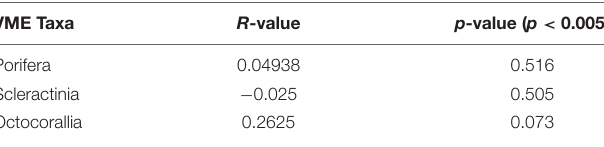
TABLE 1 | Statistical analysis of representations of deep-sea VME biogeography using physical